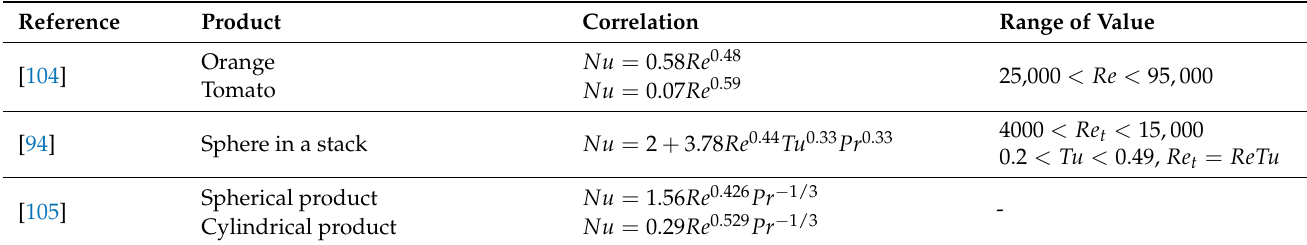
Table 5. Nu-Re correlations found in the literature. Data extracted from